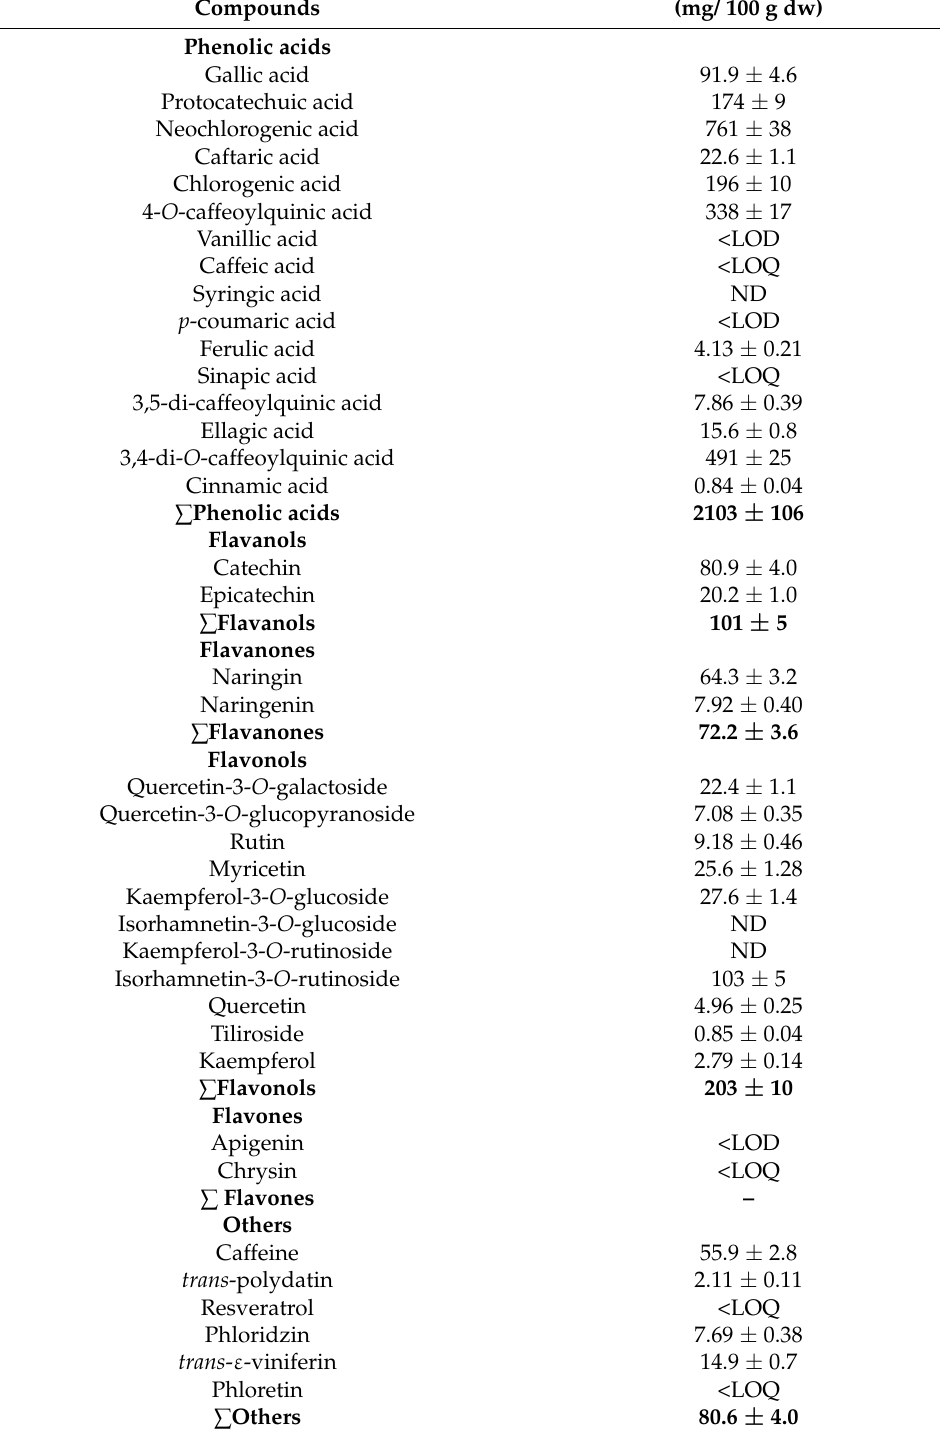
Table 4. Identification and quantification of the phenolic compounds and others present in the optimal extract from kiwiberry leaves through HPLC-PDA analysis. Results are expressed as mean ± standard deviations (mg of phenolic compound/100 g